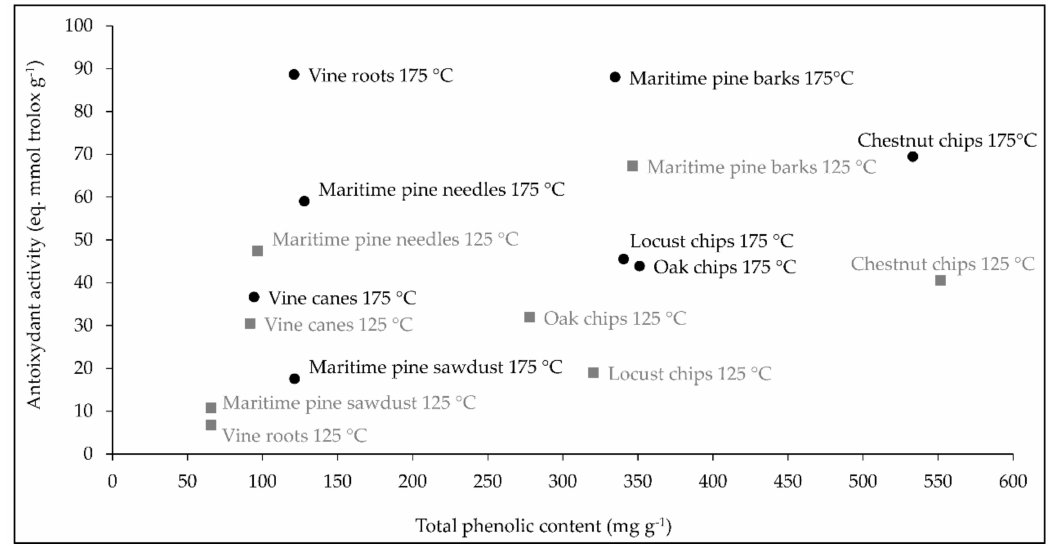
Figure 1. Correlation between total phenolic content and antioxidant activity of extracts obtained at 175 ◦ C (black circles) and extracts obtained at 125 ◦ C (gray squares). Data are means using three biological